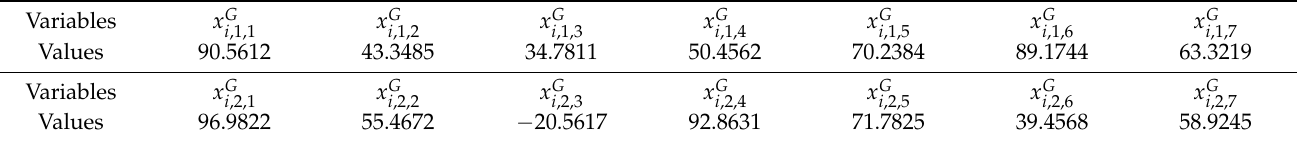
Table 2. An example of a solution for T =